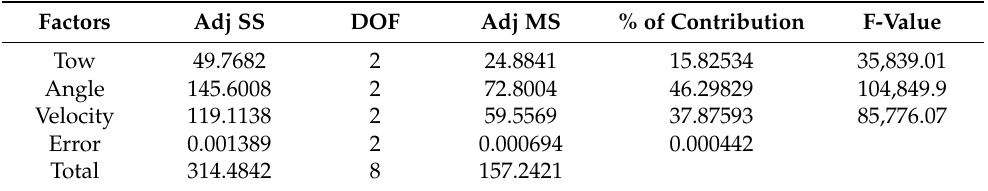
Table 8. ANOVA results for R a